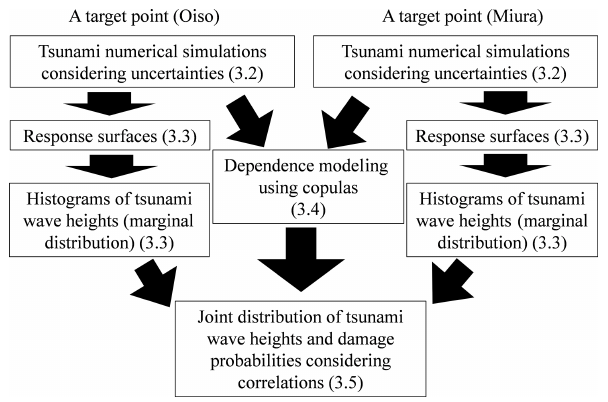
Figure 1. Flowchart of probabilistic tsunami hazard and risk as- sessment considering the spatial correlation of tsunami wave height. Numbers in the parentheses indicate the section numbers